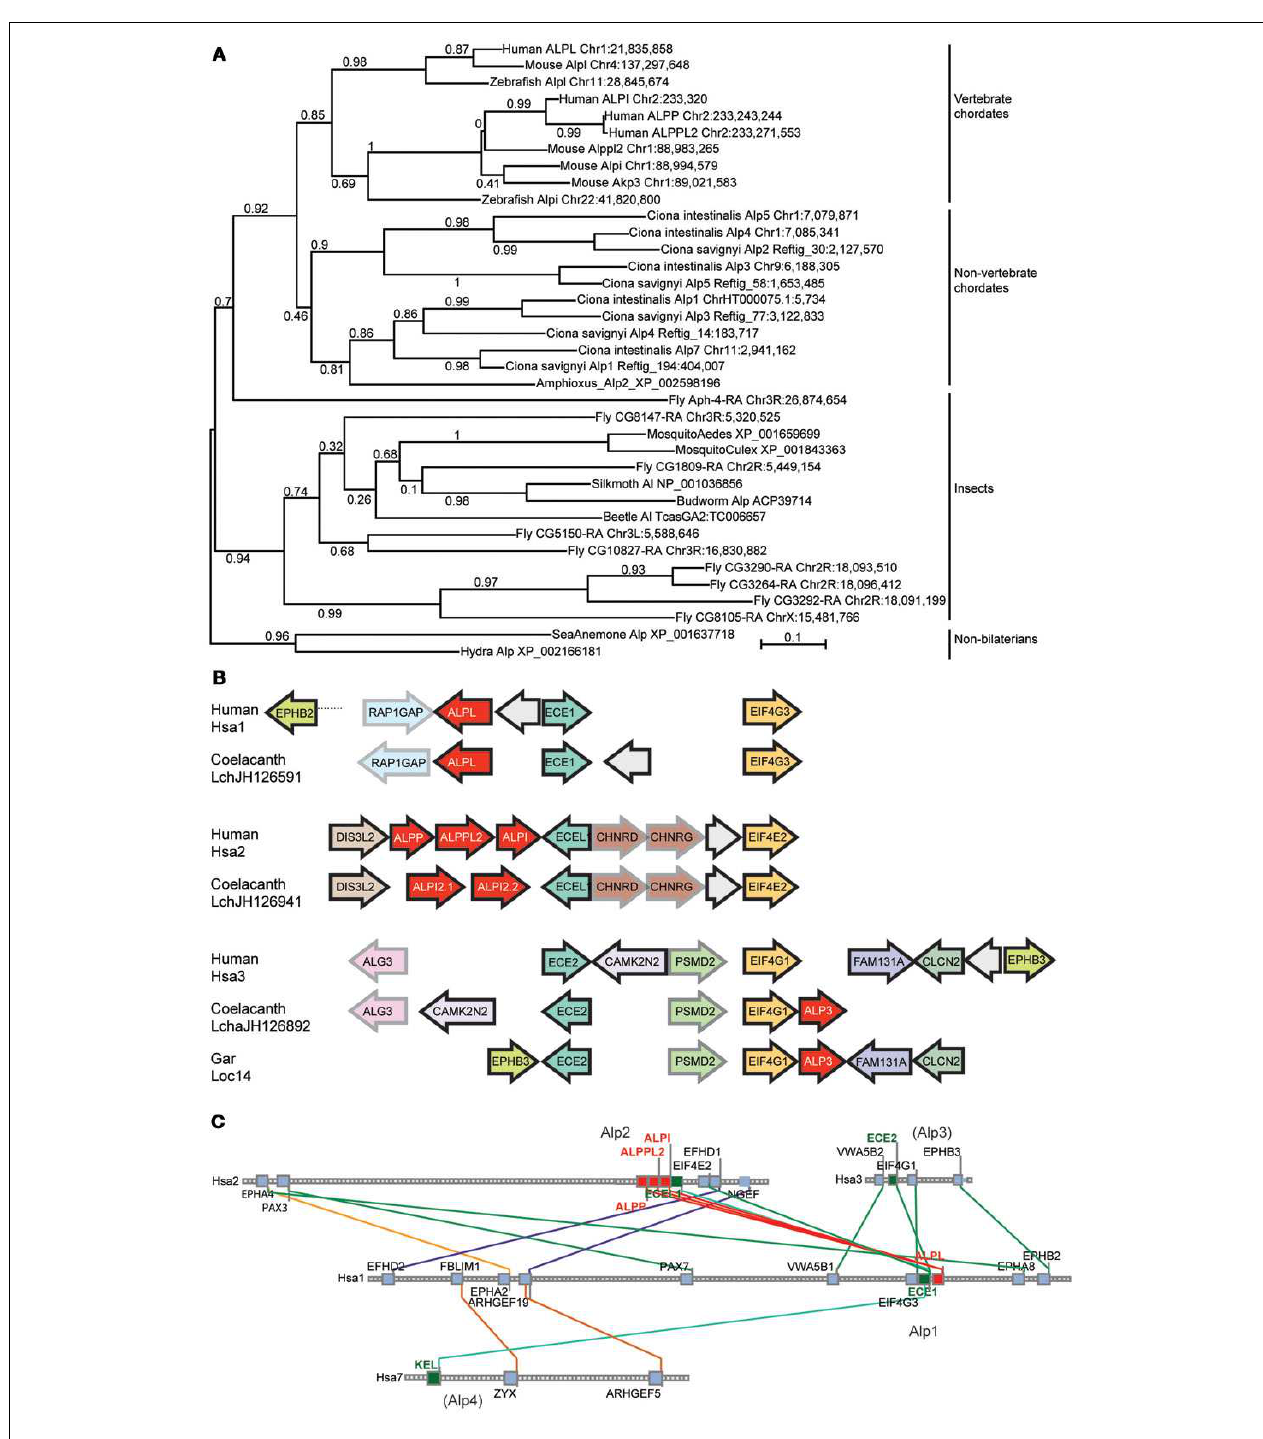
shown in unifying colors. Arrows represent direction of transcription. (C) Conserved syntenies in four paralogons in the human genome, only two of which have ALP genes.The figure shows four human chromosomes, Hsa1, Hsa2, Hsa3, and Hsa7, with lines between chromosomes connecting paralogs. Each square represents a gene; small gray squares from which no lines extend are genes without paralogs in the regions